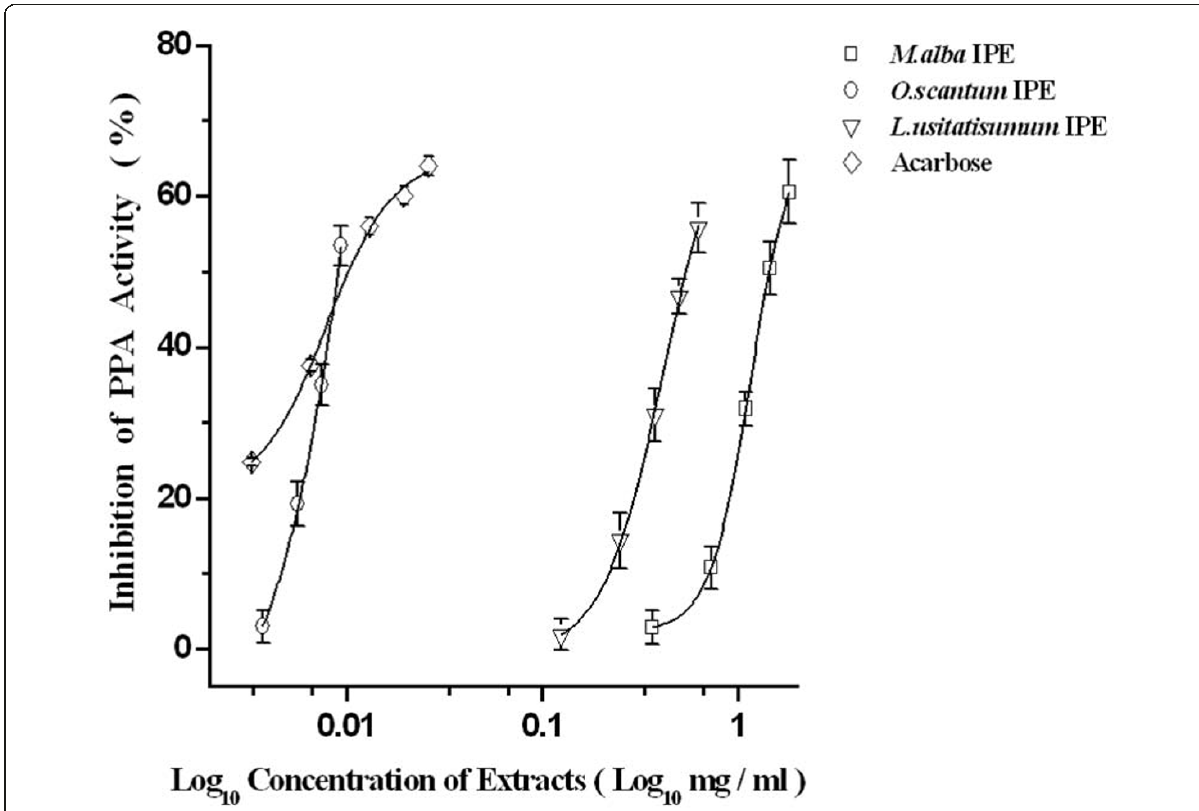
Figure 2 The percent Porcine Pancreatic a -amylase inhibition (%) of different extracts at varying concentrations. The data is indicated as the mean ± SEM; (n = 3). (P < 0.05). IPE - Isopropanol Extract.